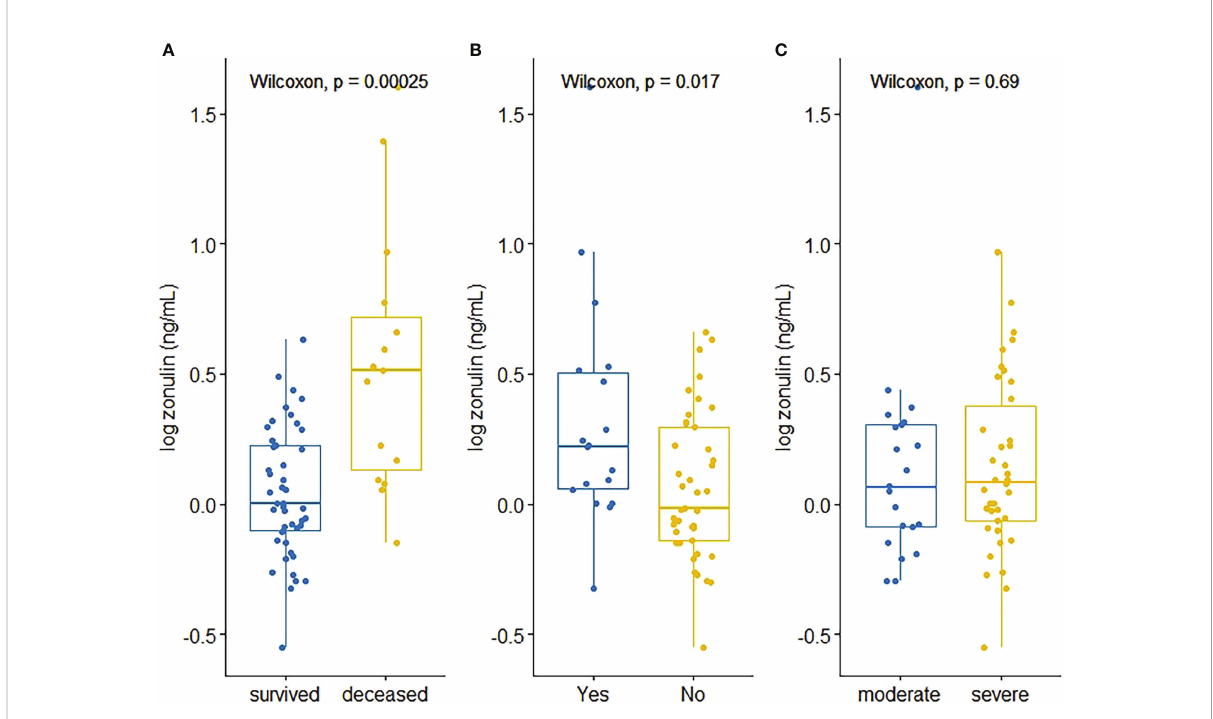
FIGURE 2 Zonulin concentrations by (A) outcome, (B) obesity and (C) disease